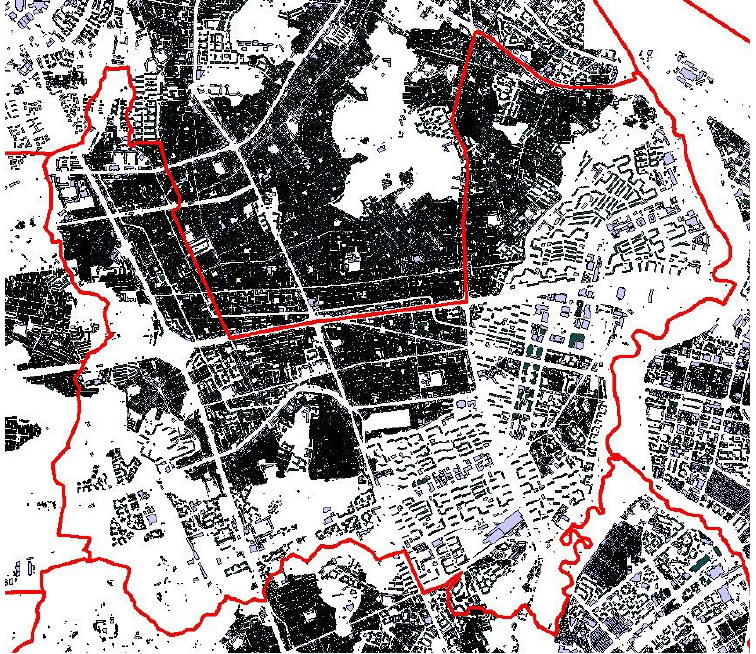
Figure 3. 3D geographical data of research field. Buildings of the research area by